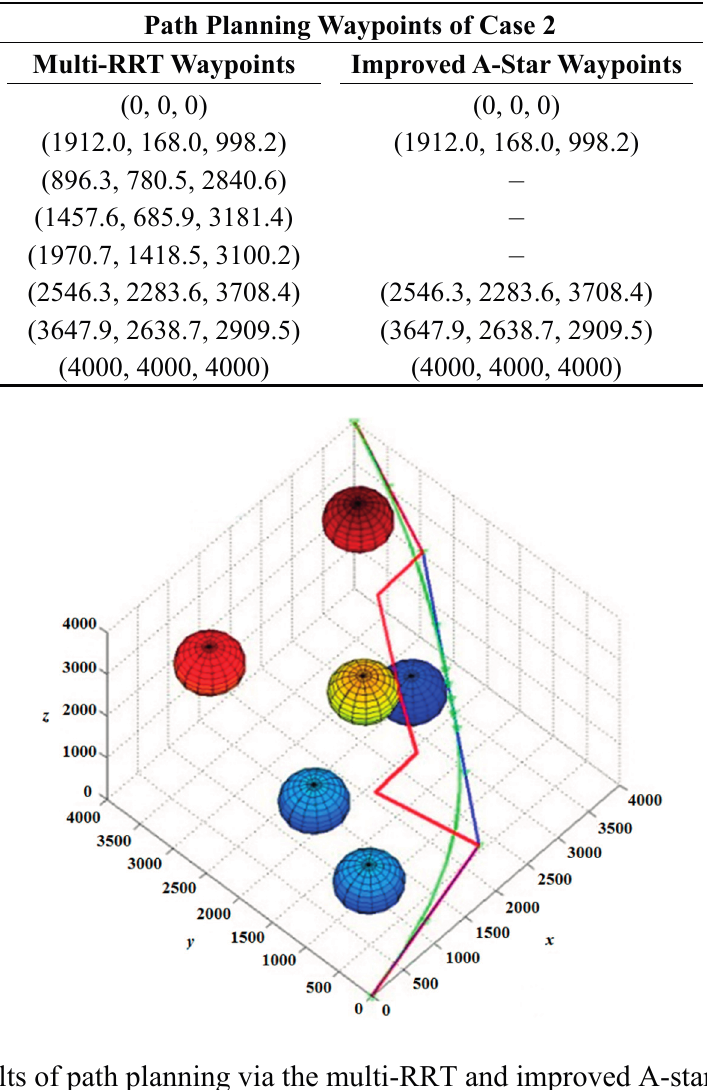
Table 2. Waypoints of the paths generated by the multi-RRT and improved A-star algorithms.